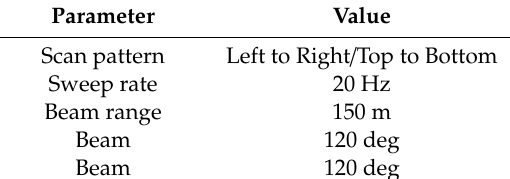
Table 4. Radar sensor parameter configuration.